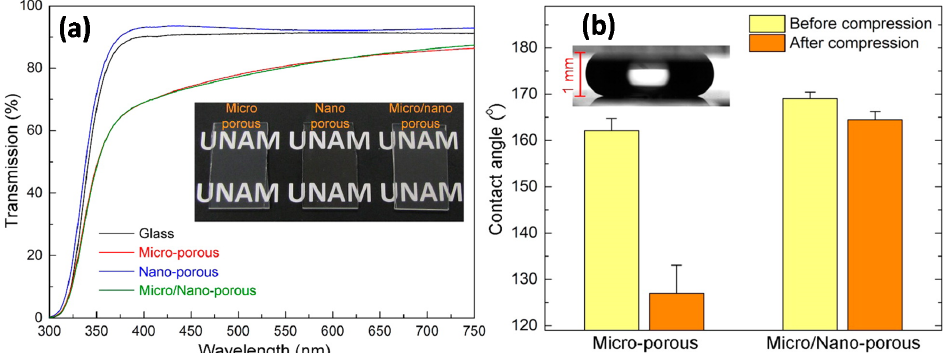
Figure 3. ( a ) Transmission spectra of ormosil coatings and an uncoated glass substrate. All of the coatings are highly transparent at the visible wavelengths. The inset shows a photograph of transparent coatings; ( b ) Droplet squeezing between two identical surfaces. Contact angles of surfaces before and after compression. The inset shows the squeezed water droplet between two MNC surfaces. There is only a slight decrease in the contact angle of the MNC after compression. The large decrease in the MC shows loss of the superhydrophobic property [3]. The changes of the apparent contact angle, contact ‐ angle hysteresis, and sliding ‐ angle values of